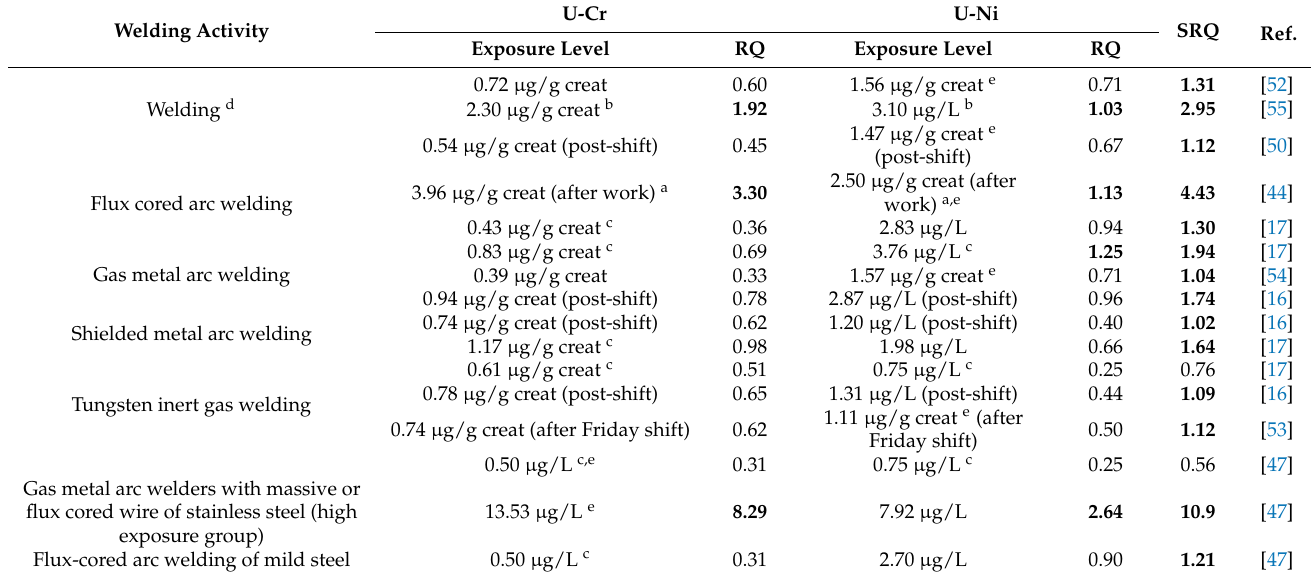
Table 4. Exposure levels of Cr and Ni in urine (HBM) of workers performing welding activities, and values obtained for RQ and